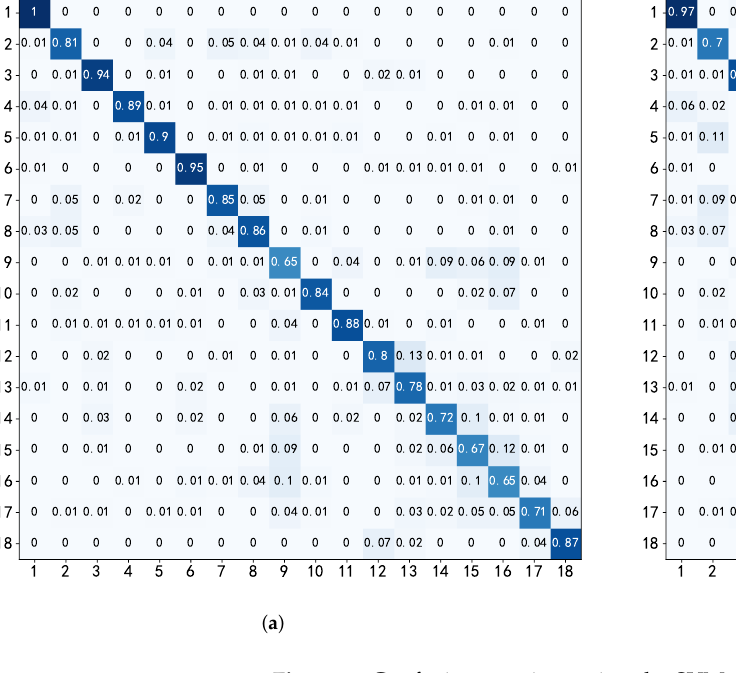
Figure 8. Confusion matrices using the SVM classifier with 10-fold and LOSO validation scheme. The posture categories are represented in Figure 2. ( a ) 10-Fold (SVM). ( b ) LOSO (SVM).